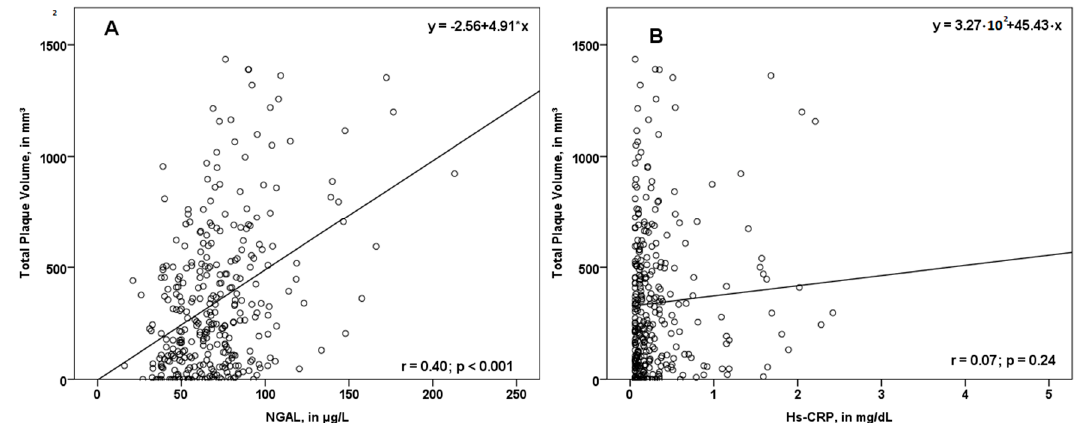
Figure 2. Scatterplot displaying the association of NGAL ( A ) and hs-CRP ( B ) with total plaque volume (PV). While NGAL was associated with total PV, hs-CRP did not correlate significantly with the total plaque volume. NGAL—neutrophil gelatinase-associated lipocalin; hs-CRP—high sensitivity C-reactive protein; r—correlation coe ffi cient.